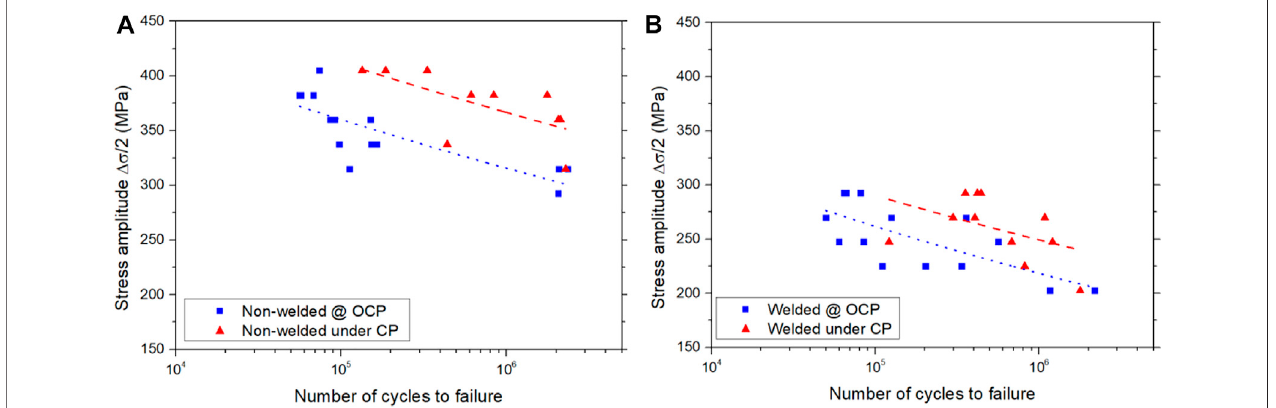
FIGURE 11 | SN curves obtained under CP and at OCP on (A) non-welded specimens and (B) specimens with an orbital weld.